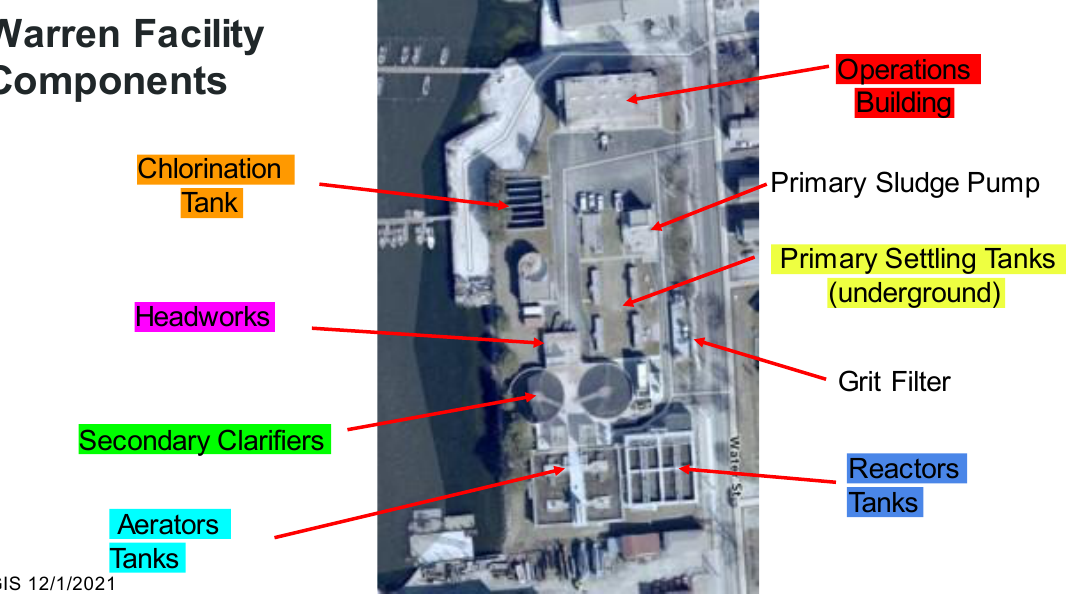
Figure 3. Major components of the Warren, RI WWTF. These are color coded to help in presenting the results of the analysis. Grit filter and primary sludge pump are not color coded since they experience only limited damage for short term flooding.